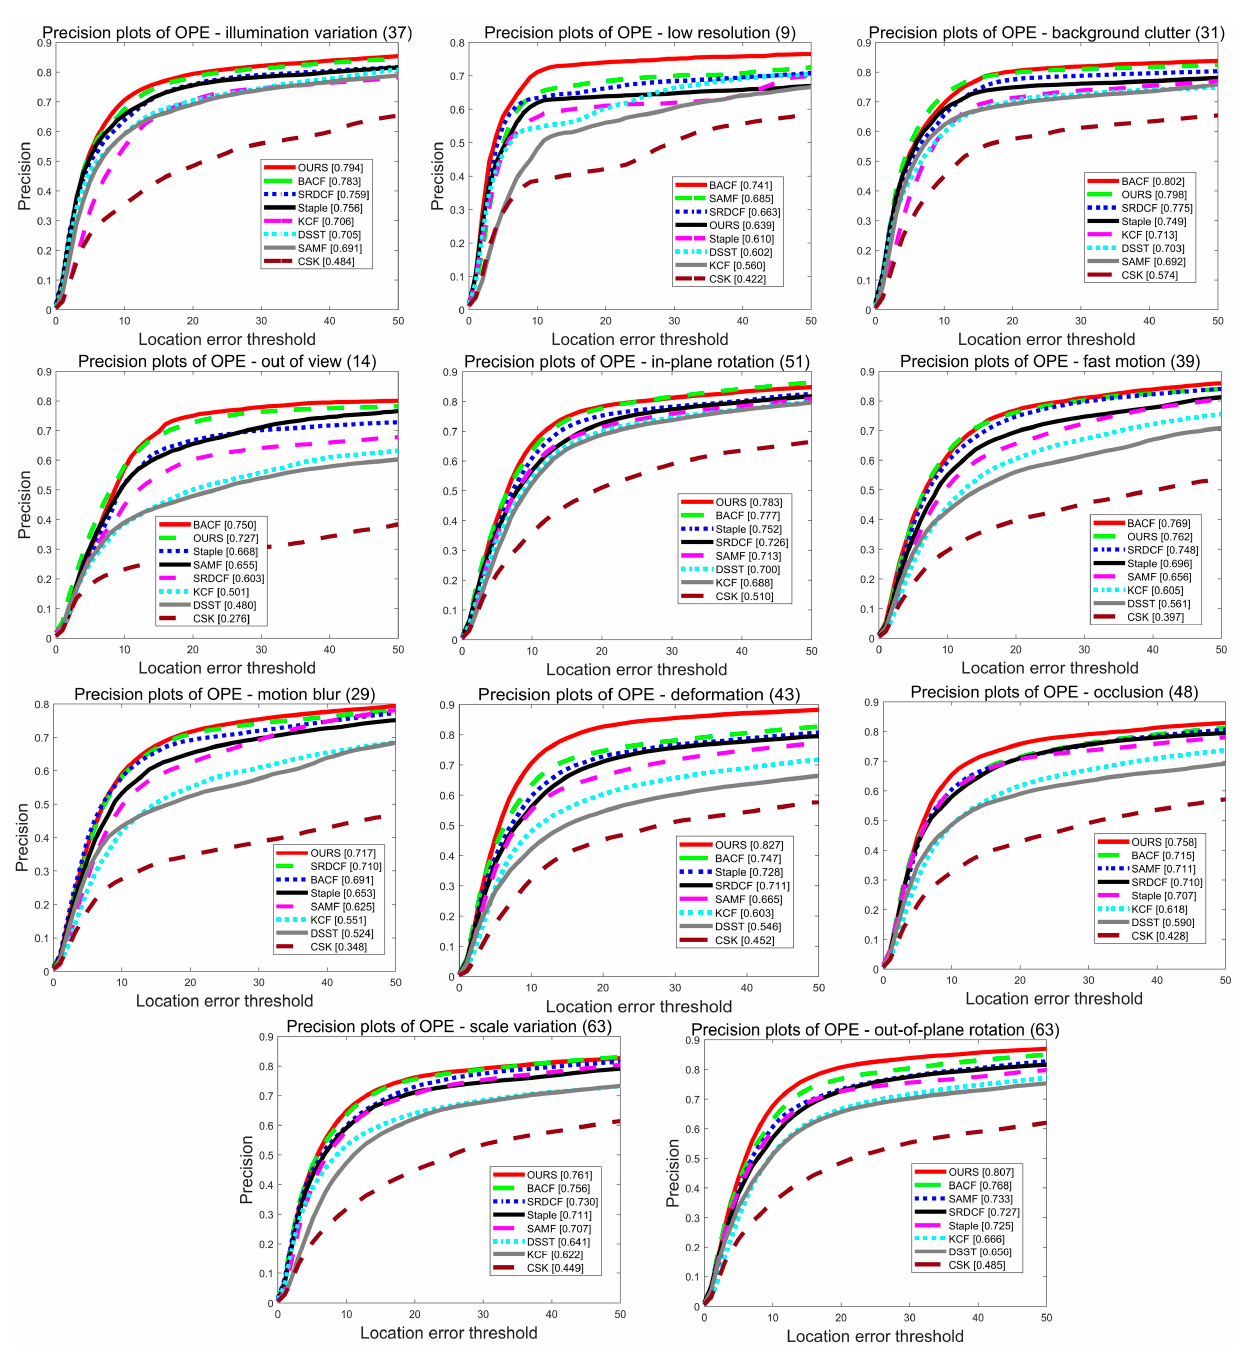
Figure 4. The precision plot of eight algorithms for 11 challenge scenarios on the OTB-2015 dataset.